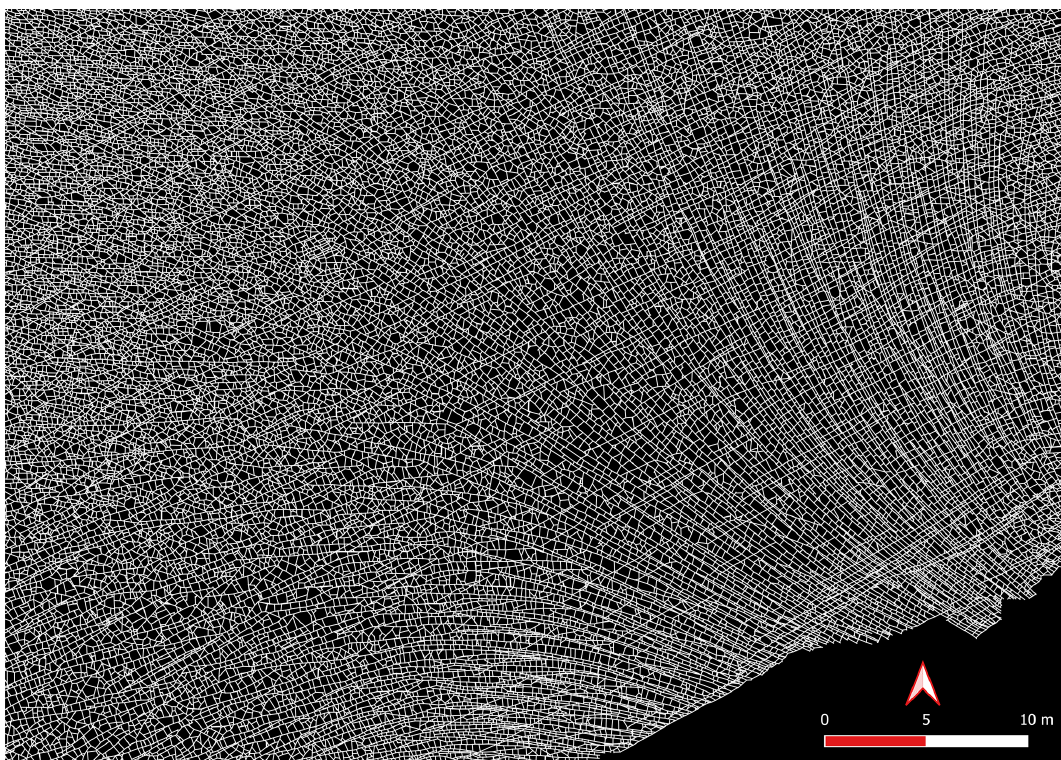
Figure 7. Cutout from Region 2 depicting the detailed resolution of the fracture dataset.